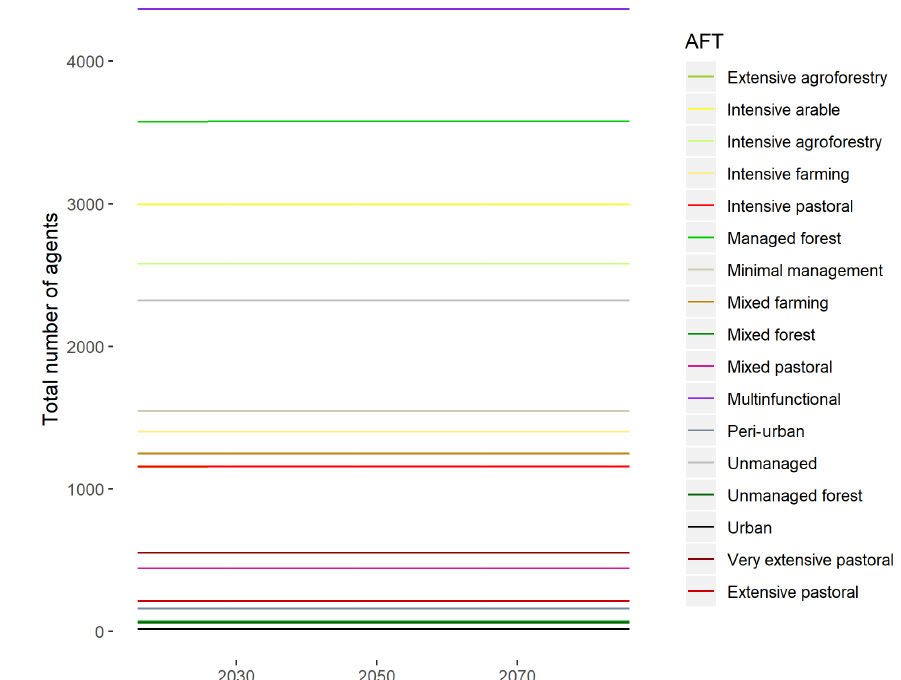
Figure B4. Numbers of agents belonging to each agent functional type throughout the “baseline” run, in which CRAFTY-EU was initialised with the baseline land use map and run under static